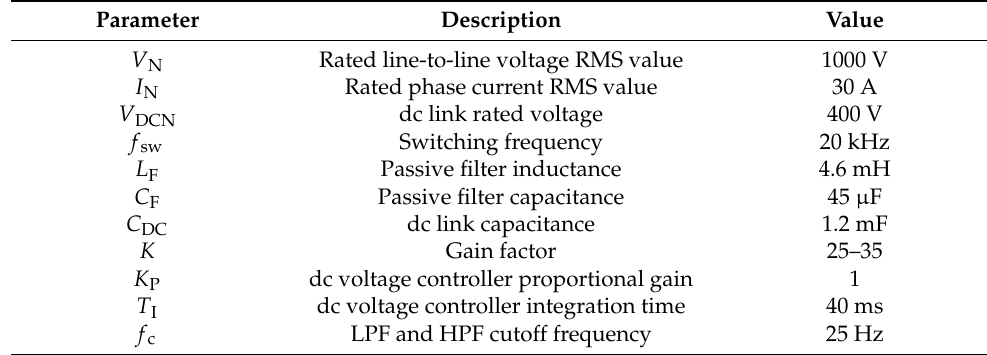
Table 2. Rated parameters of the prototype of the hybrid active power filter